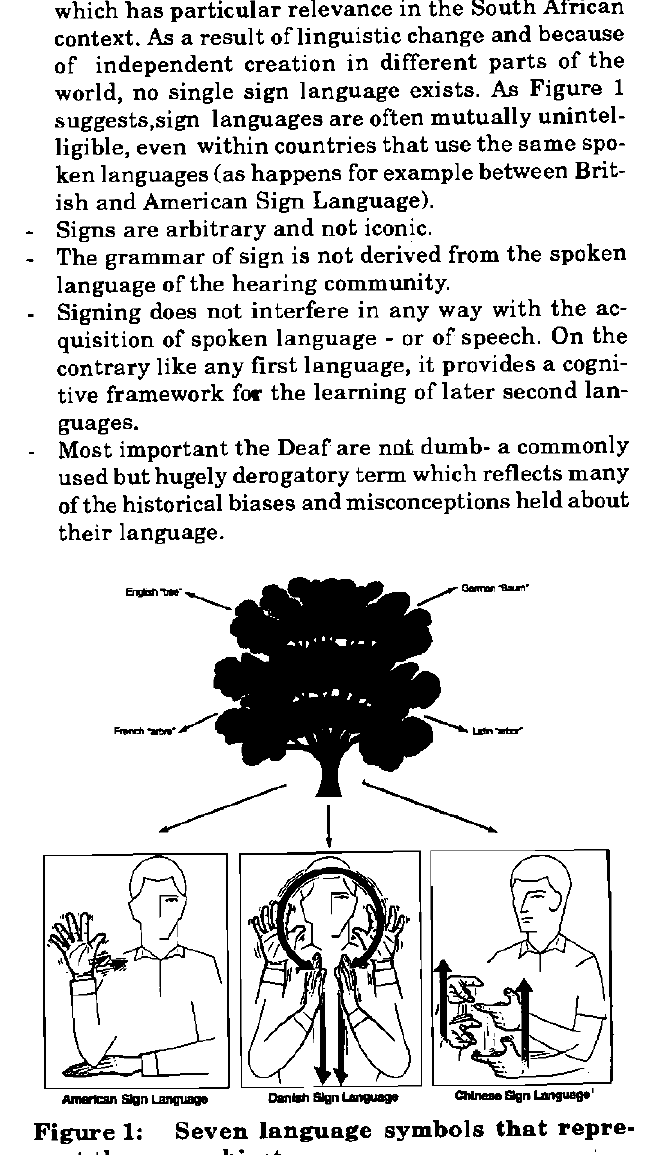
Figure 1: Seven language symbols that repre- sent the same